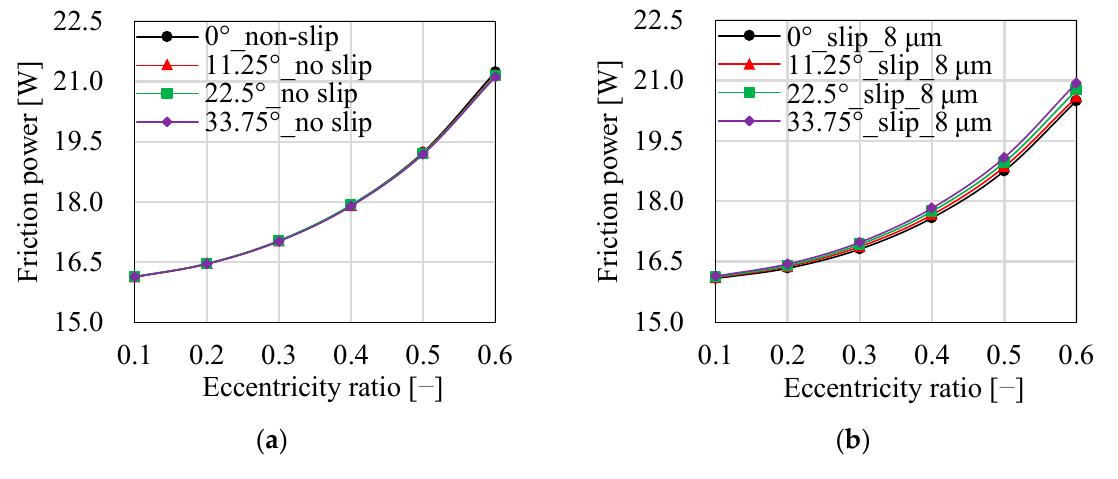
Figure 13. Comparison of the friction power under different attitude angles; ( a ) non-slip boundary conditions; ( b ) slip velocity.